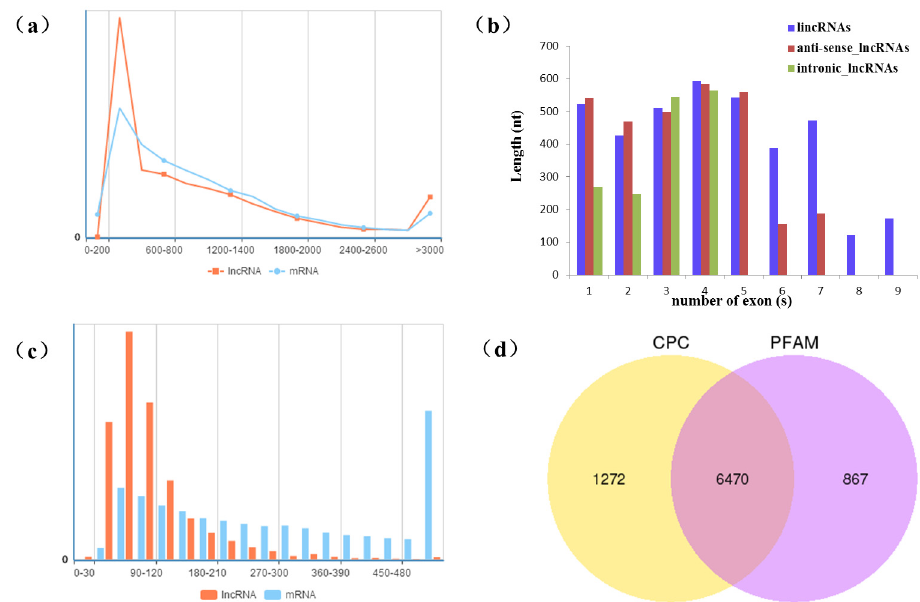
Fig 2. Characterization analysis of lncRNAs. (a) The length compassion analysis of lncRNA and mRNA. X axis indicates the length of lncRNAs and mRNAs (bp), while Y axis represents the frequent count. (b) The features of different types of lncRNAs, including lincRNAs, anti-sense_lncRNAs and intronic_lncRNAs. (c) The ORF compasion analysis of lncRNA and mRNA. X axis indicates the number of ORFs, while Y axis represents the frequent count. (d) Coding potential prediction of lncRNAs by CPC and PFAM software. Venn diagrams show number of lncRNAs with coding potential.